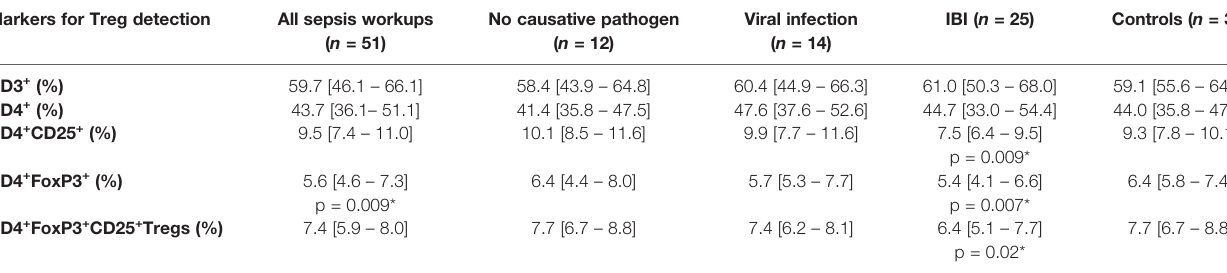
TABLE 3 | Frequencies of T cells and Tregs strati fi ed to subgroups. Markers for Treg detection